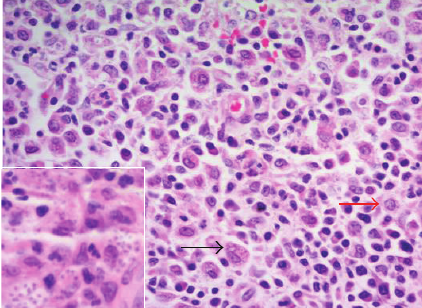
Figure 1: Dog. Vaginal vestibule, red verrucous, and lobulated mass protruding from the vagina.